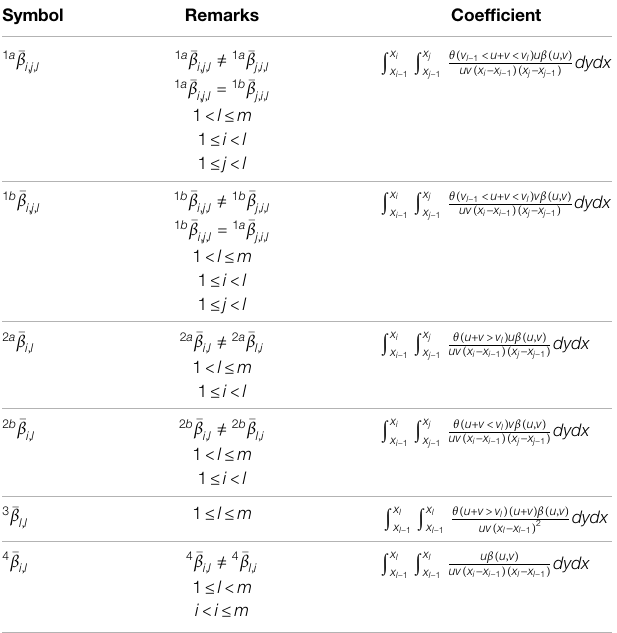
TABLE 1 | Coagulation coef fi cients (Gelbard and Seinfeld, 1980).